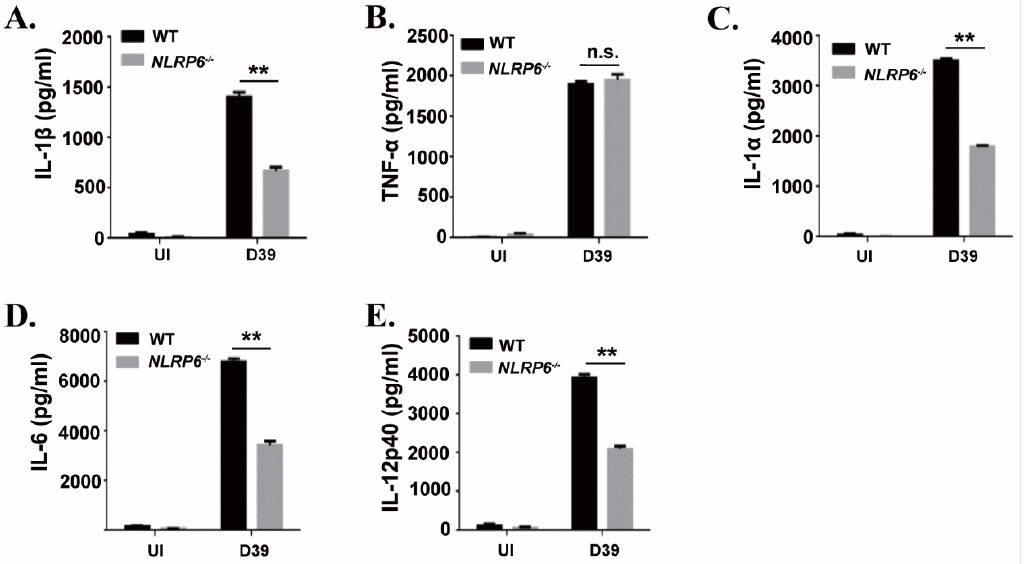
Figure 1. NLR family pyrin domain containing 6 (NLRP6) mediates inflammatory cytokines expression in S. pneumoniae - infected macrophages. Macrophages from WT or NLRP6 − / − mice were uninfected or infected with S. pneumoniae at a multiplicity of infection (MOI) of 1 for 6 h. Then, gentamicin (100 µ g/mL) was added to the cultures and incubated for 18 h. After 24 h infection, the supernatants were collected and the levels of IL-1 β ( A ), TNF- α ( B ), IL-1 α ( C ), IL-6 ( D ) and IL-12p40 ( E ) in the supernatants were determined by ELISA. All of the experiments were independently performed three times. Statistical significance was determined by Student’s t -test (** p < 0.01).